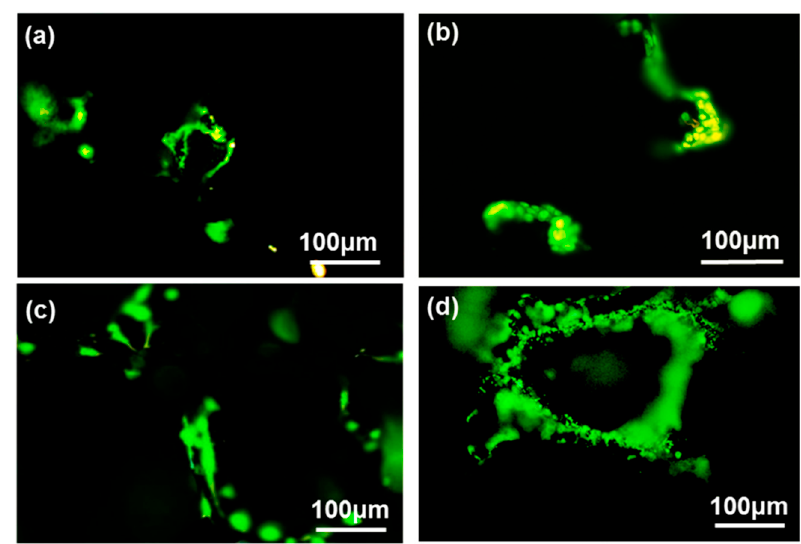
Figure 6. Cytotoxicity of graphene-hydroxyapatite hybrid (GHB) scaffold on MC3T3-E1 cells. ( a , b ) second and fourth day(3D Graphene Foam) ( c , d ) 2nd and 4th day (3D GHBs), respectively [72] (copyright 2018, Crystals).